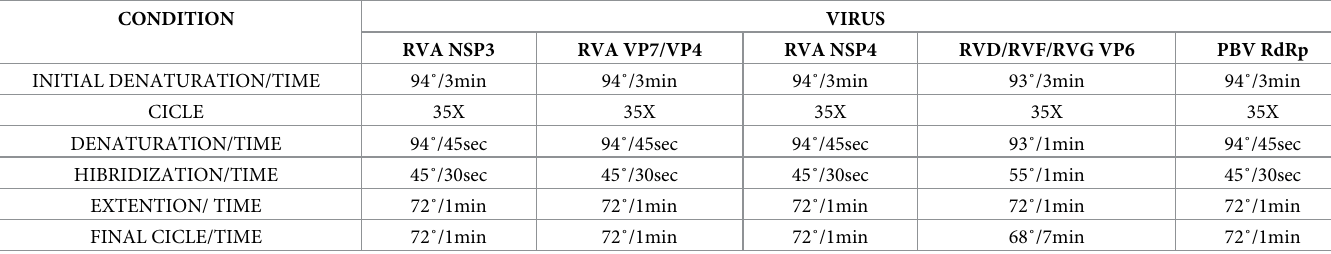
Table 2. RT-PCR/Nested conditions for amplification for rotavirus and